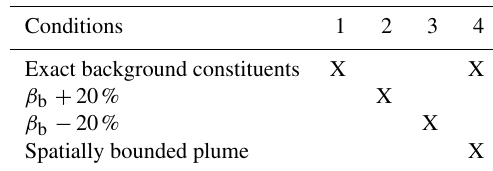
Table 2. Conditions placed on the optical properties of the back- ground components for the inversion method.